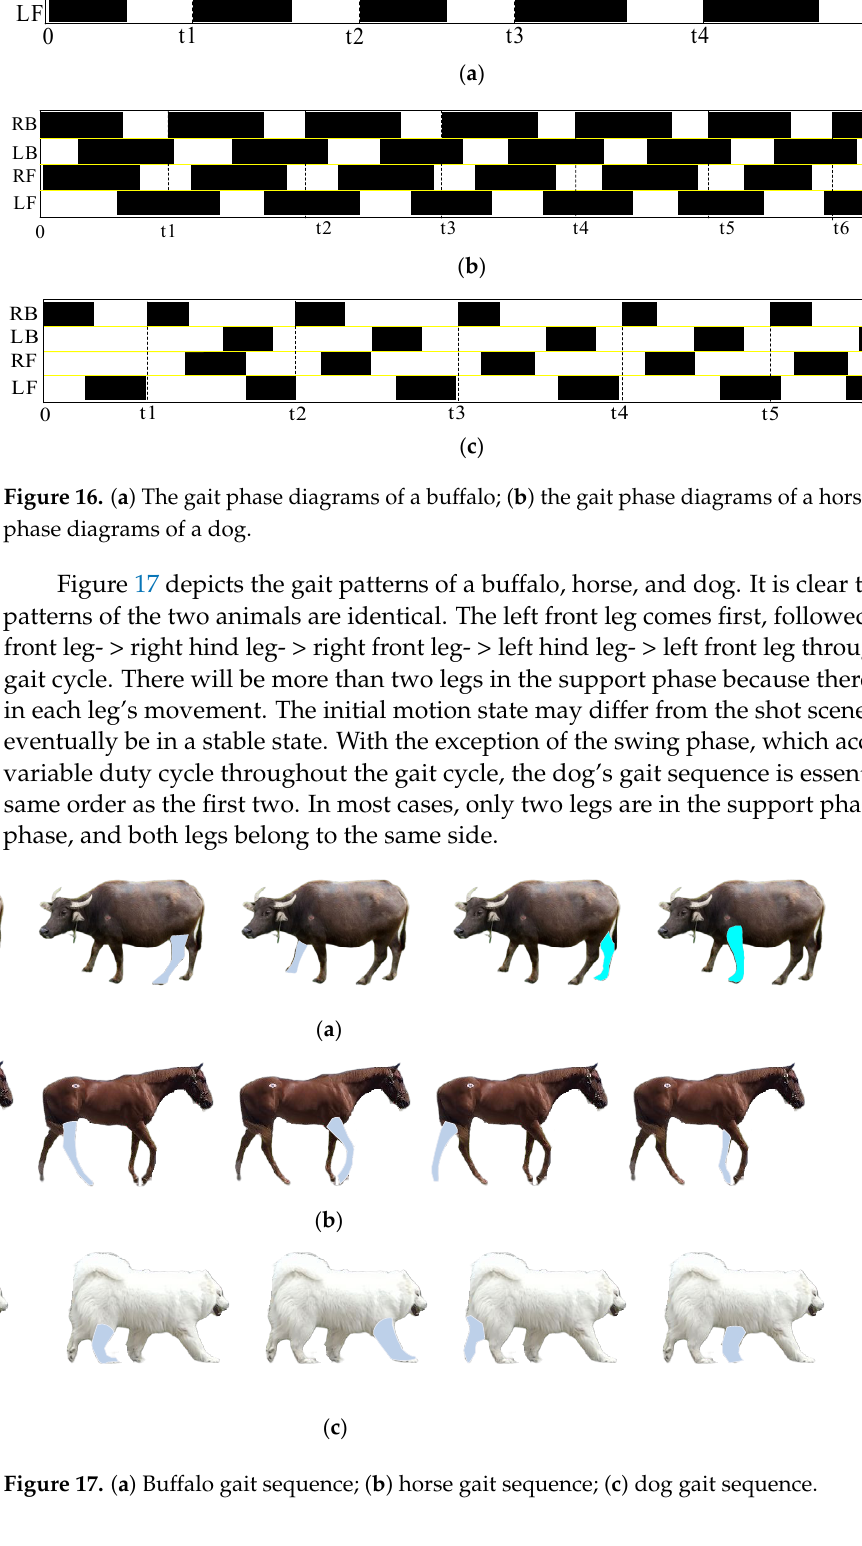
( b ) Figure 18. ( a ) Buffalo’s gait cycle curves of LF, RF leg; ( b ) buffalo’s gait cycle curves of LB, RB leg. 0